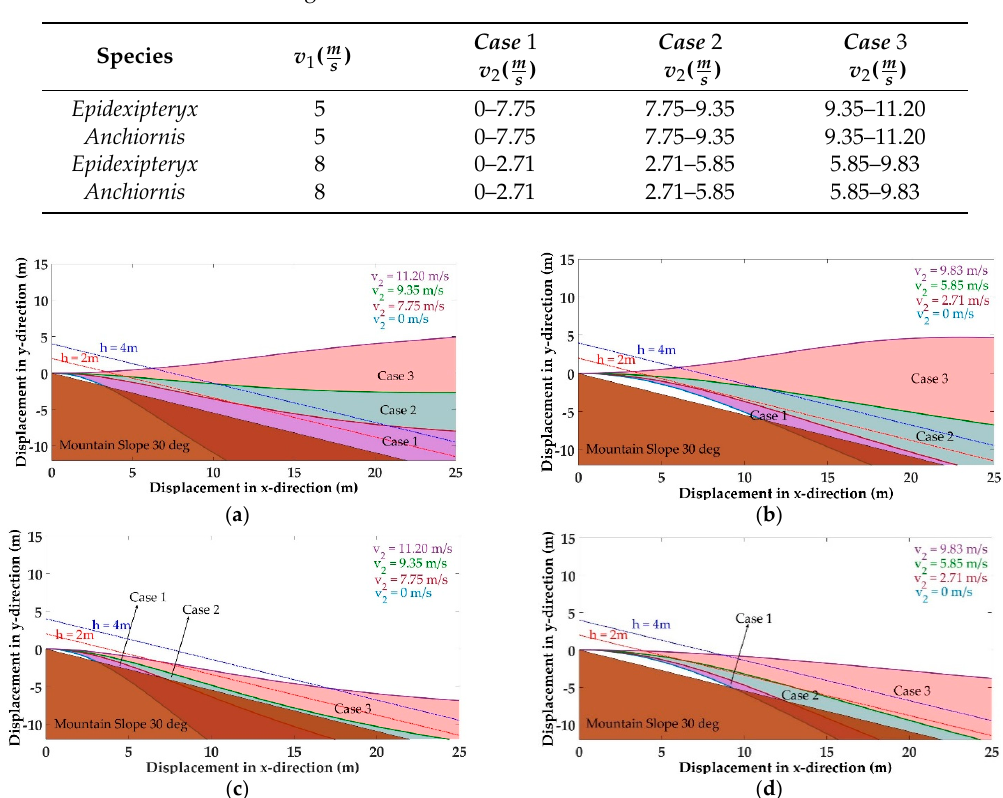
Table 2. The speed of the upslope wind in different cases when the species ran at the speeds of 5 m/s and 8 m/s and the inclined angle was θ =30 ◦ .